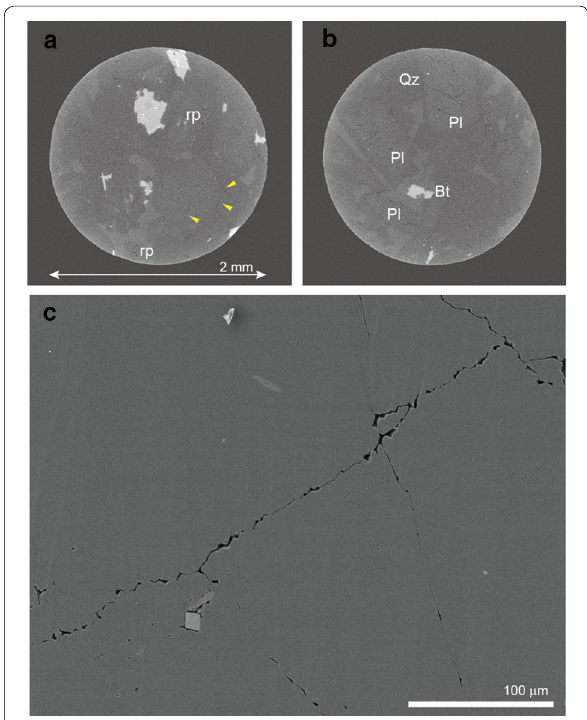
Fig. 5 a , b Radial cross-sectional images of X-ray CT of a cylindrical sample ( D 2 mm, L 6 mm). Cross sections are parallel to ZX -plane = = of a cylindrical sample AJG02. Lots of cracks (arrows) and round pores (rp) are imaged, and there many intragrain cracks in plagioclase grains. c An SEM image of ion-milled surface of